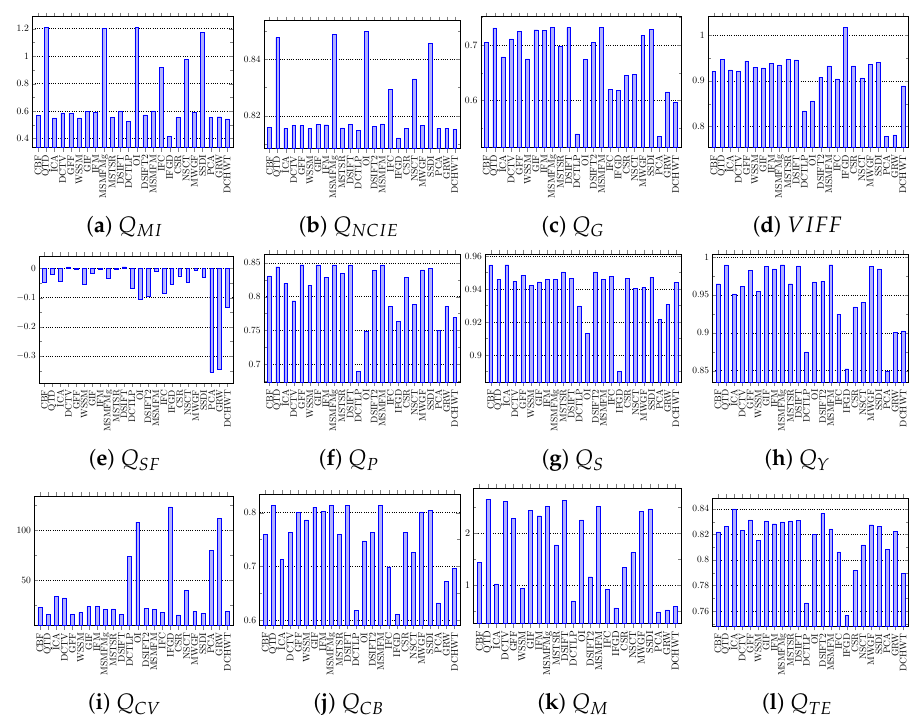
Figure 8. Performance of different image fusion algorithms on the Lytro dataset using objective fusion quality assessment metrics. Table 3. Summary of performance evaluation using information based metrics. For each metric, the numbers (1), (2), and (3) show the three best performing algorithms, respectively. Metric Grayscale Lytro